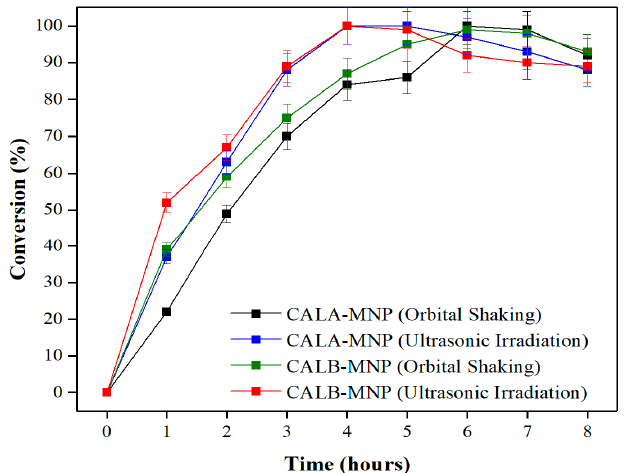
Figure 4. Esterification course for ethyl butyrate synthesis biocatalyzed by CALA-MNP or CALB-MNP under orbital shaking (150 × rpm ) or ultrasonic irradiation (37 kHz and 300 W). Reaction medium: CALA-MNP (10 mg) or CALB-MNP (12.5 mg), 1:1 (butyric acid/ethyl alcohol) and heptane (reaction